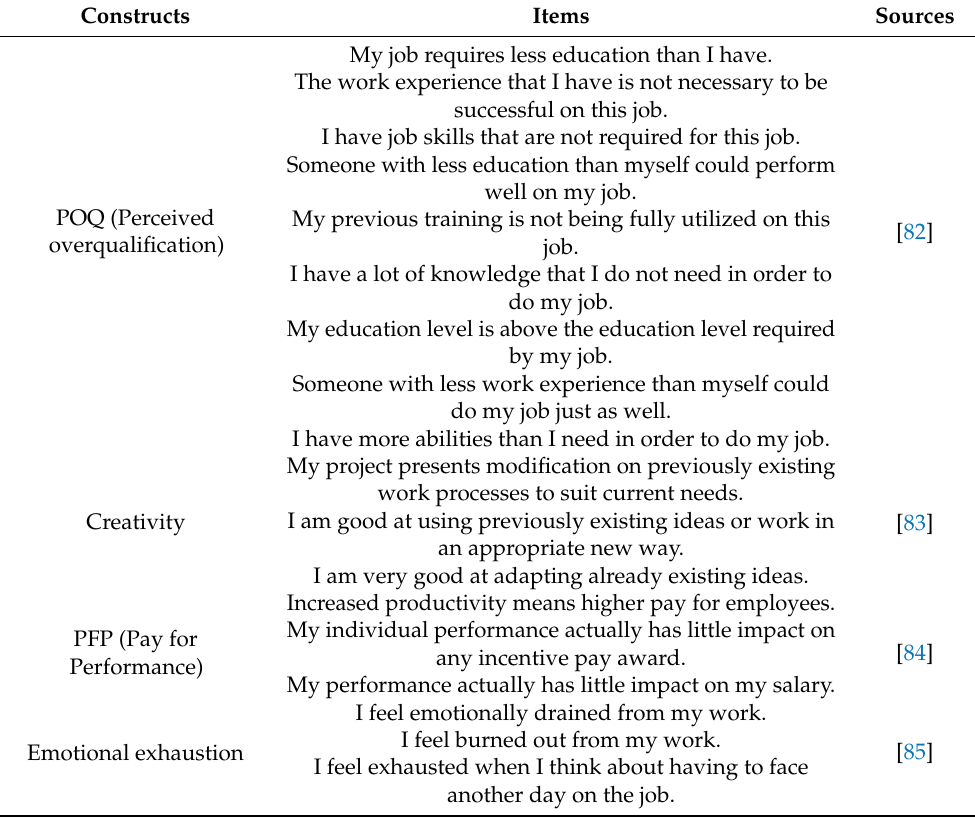
Table 1. Constructs and